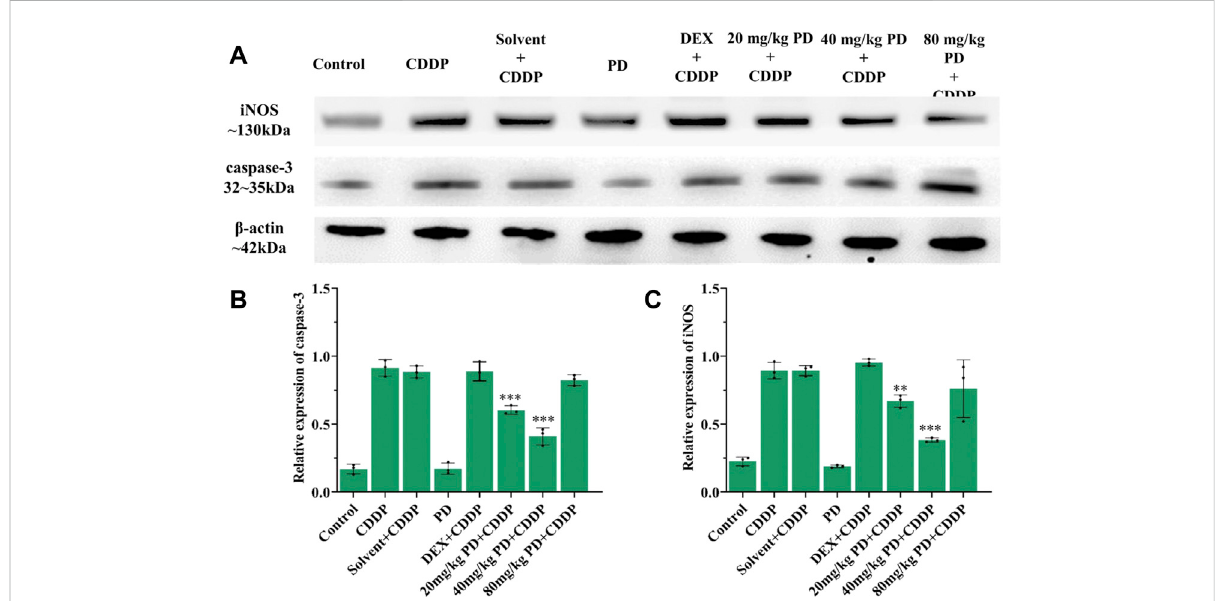
FIGURE 10 PD reduces cisplatin-induced cochlear oxidative damage. (A) The expression of iNOS and caspase-3 in each group after 3 days of drug administration. (B) and (C) PD administration before cisplatin decreased the expression of iNOS and caspase-3 in a concentration-dependent manner, presenting as PD (40 mg/kg) > PD (20 mg/kg) > PD (80 mg/kg). The effect of PD (40 mg/kg) was better than that of DEX (10 mg/kg, multi- dose) ( p < 0.001). PD (40 mg/kg) injection alone did not cause oxidative stress damage and the increase of iNOS and caspase-3 expression